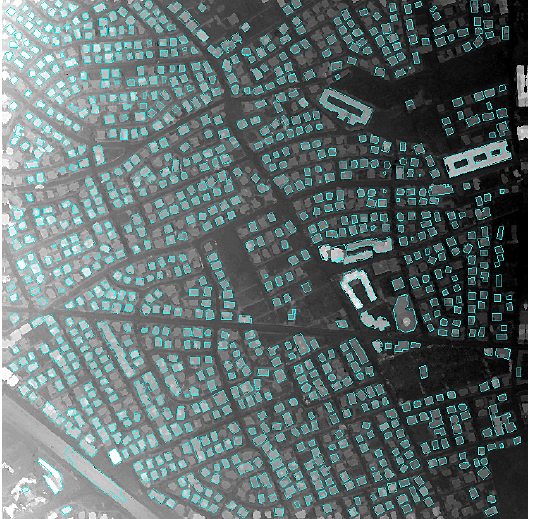
As an alternative to the RANSAC based approximation algo- rithm, a method similar to MBR-based is proposed for the build- ings containing several orientation directions. The method called Combined Minimum Bounding Rectangle (CMBR) based algo- rithm for hierarchical approximation of non-rectangular polygons.